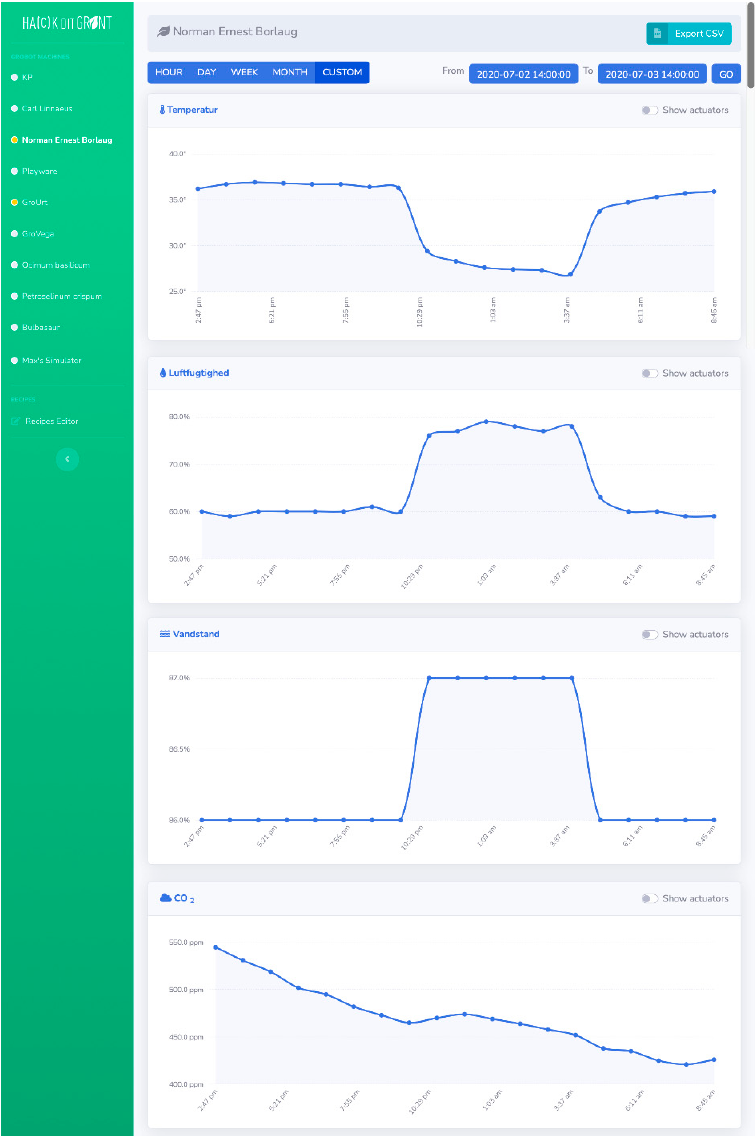
Figure 10. The web interface shows the status of the GrowBot sensors. The graphs show temperature, air humidity, water level, CO 2 (top to bottom).